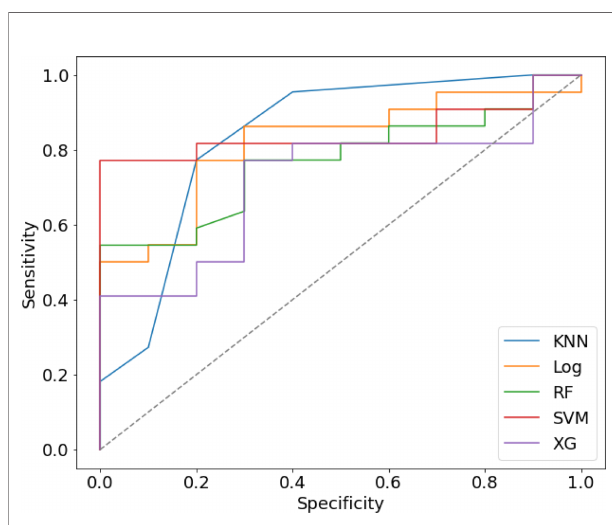
FIGURE 4 | The Receiver operating characteristic (ROC) curve of fi ve prediction models in validation cohort.